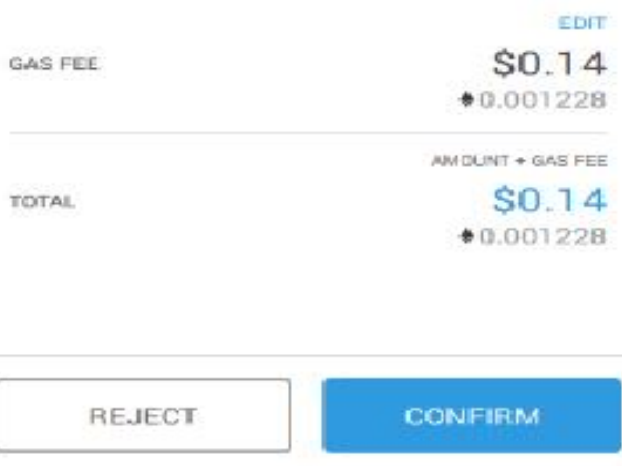
Figure 11. Uploading file by IPFS.